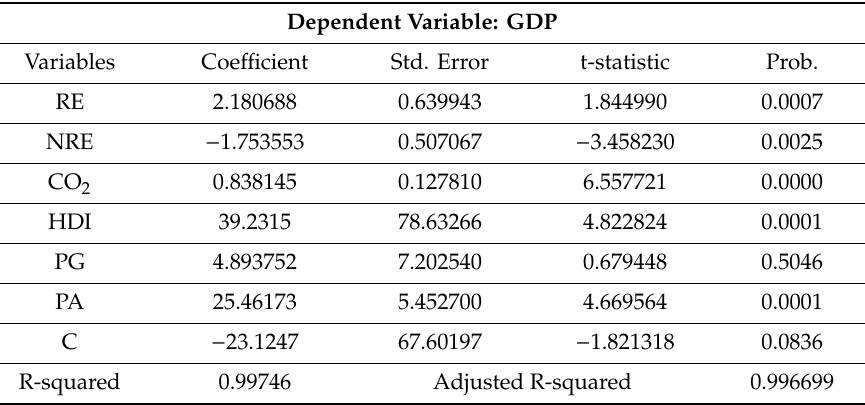
Table 2. Fully modified least squares